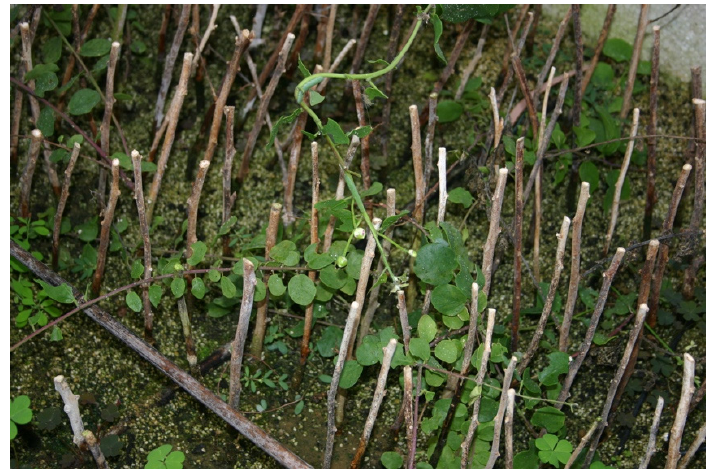
Figure 4. Vegetative propagation by rooting during experiments at the University of Palermo,